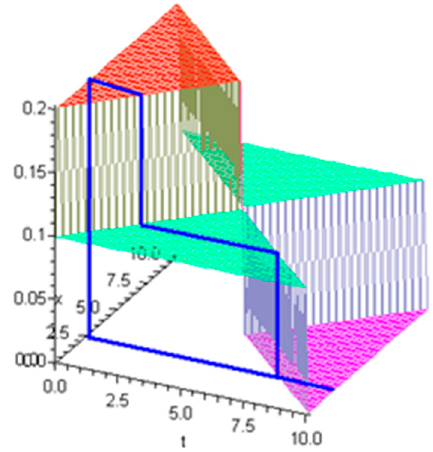
Figure 2. PDF for a semi-random trip. Figure 3. Joint PDF.